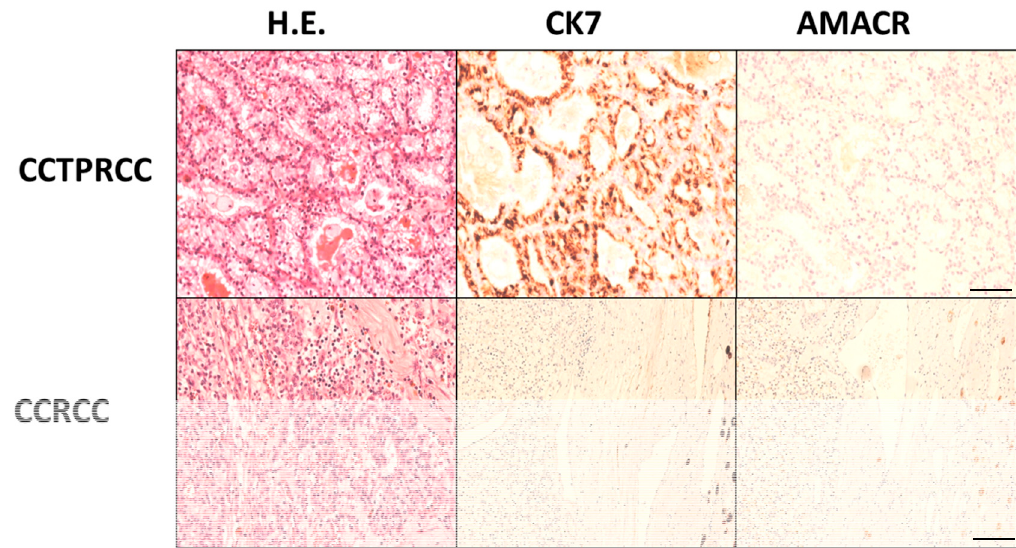
Figure 1. Differential H&E and immunohistochemical features between clear cell tubulo-papillary renal cell carcinoma (cctpRCC) and clear cell carcinoma (ccRCC). cctpRCC shows a peculiar tubular structure with little atypia and nuclei lined over the basal membrane, diffuse cytokeratin 7 (Ck7) reactivity, and negativity for racemase. ccRCC shows irregular nests of clear cells negative for both CK7 and racemase (scale bar 100 microns).